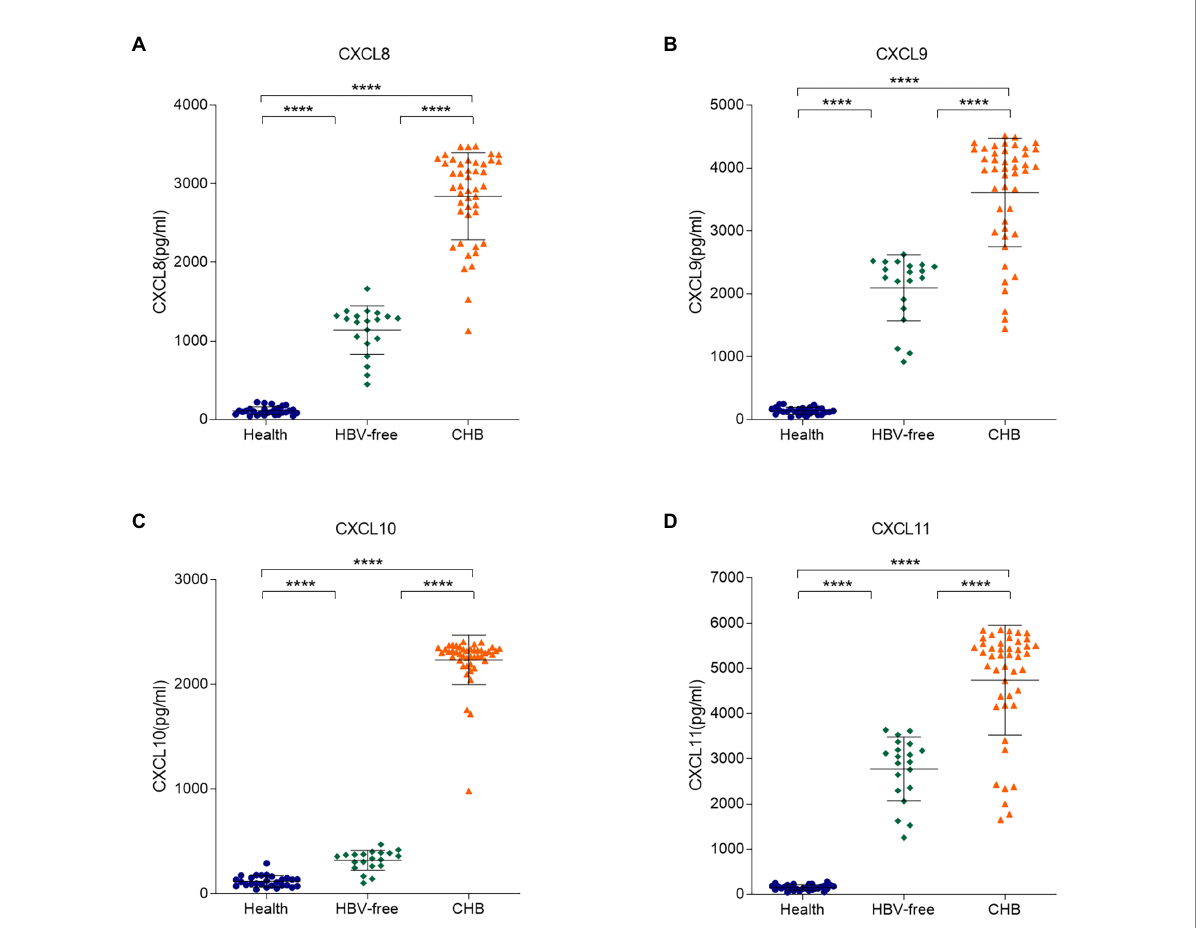
FIGURE 3 Differences in serum levels of CXCL8, CXCL9, CXCL10, and CXCL11 between the HBV-infected, HBV-free and the Healthy groups. The serum levels of (A) CXCL8, (B) CXCL9, (C) CXCL10, and (D) CXCL11 in the Healthy group, the HBV-free group and the HBV-infected group were detected by ELISA. The detection limit of CXCL8, CXCL9, CXCL10, and CXCL11 is 12.5–9,000 pg./ml, 17.8–12,000 pg./ml, 28–3,200 pg./ml and 31– 16,000 pg./ml, respectively. **** p <